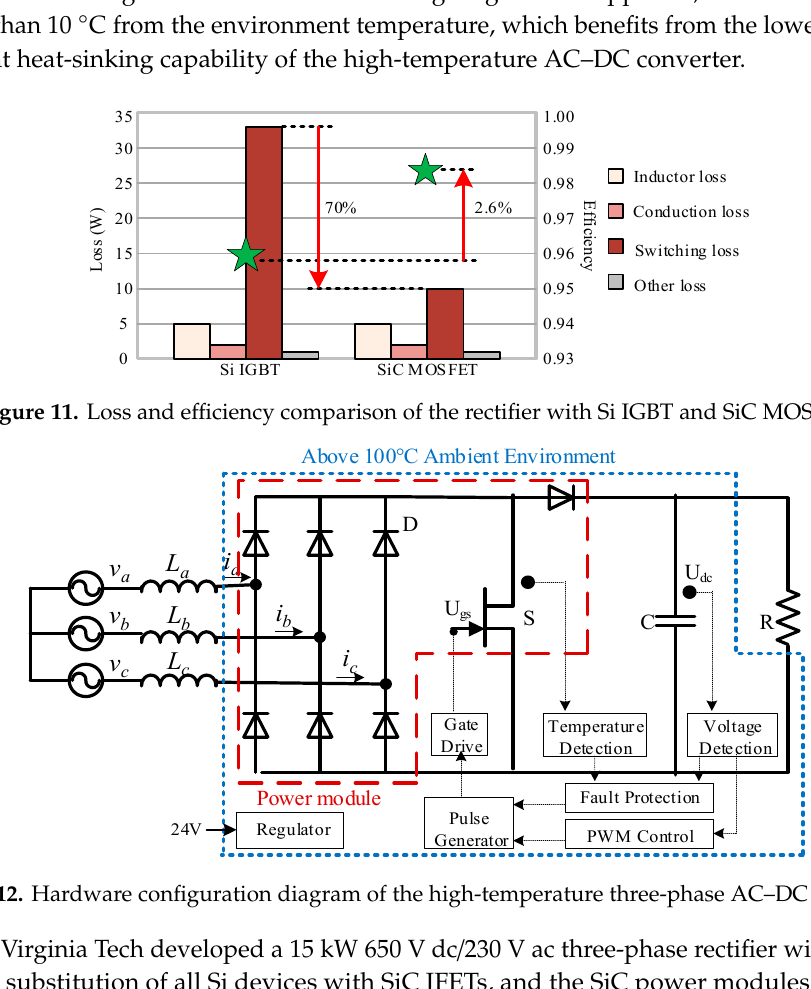
Figure 12. Hardware configuration diagram of the high-temperature three-phase AC–DC converter